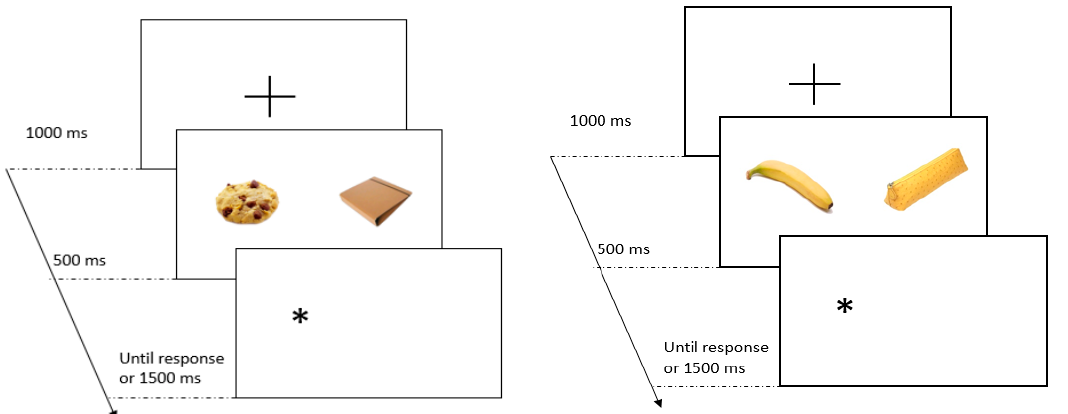
Figure 1. Two illustrations of the dot-probe task, the left with a vice product and the right with a virtue product. After participants were presented with the fixation cross, they were shown two pictures simultaneously for 500 ms, one corresponding to a food (healthy or unhealthy), and the other corresponding to a neutral pair. Finally, they were asked to press “B” if the asterisk appeared on the left side and “N” if the asterisk appeared on the right side.